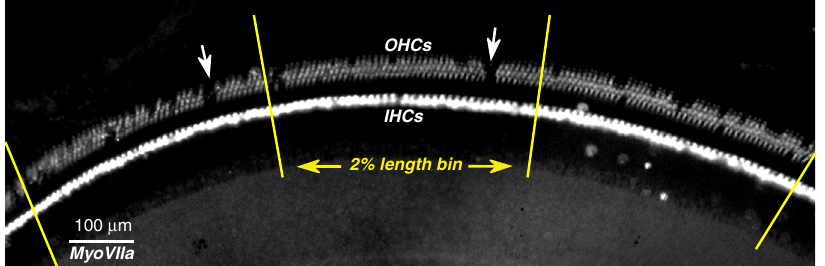
Figure 3. Low-power image of the type used to assess hair cell survival. Widefield image centered on the 13 kHz region of an ear exposed to 10 blasts @ 165 dB SPL peak. Yellow lines illustrate the boundaries used to bin the hair cell counts, corresponding to 2% increments of cochlear length. White arrows point to two regions where all three rows of OHCs are missing. OHC loss was 9.3% when averaged between the central 2% segment shown here and the segment immediately to its right: bin widths in Figs 4 and 5 are 4% of cochlear